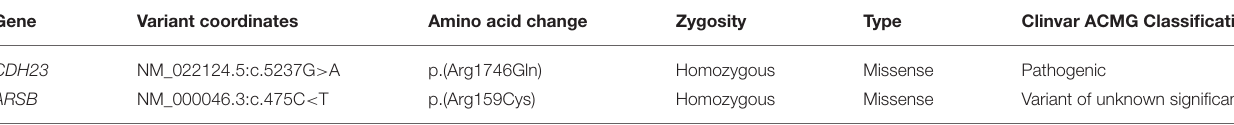
TABLE 1 | Description of variants detected during whole exome